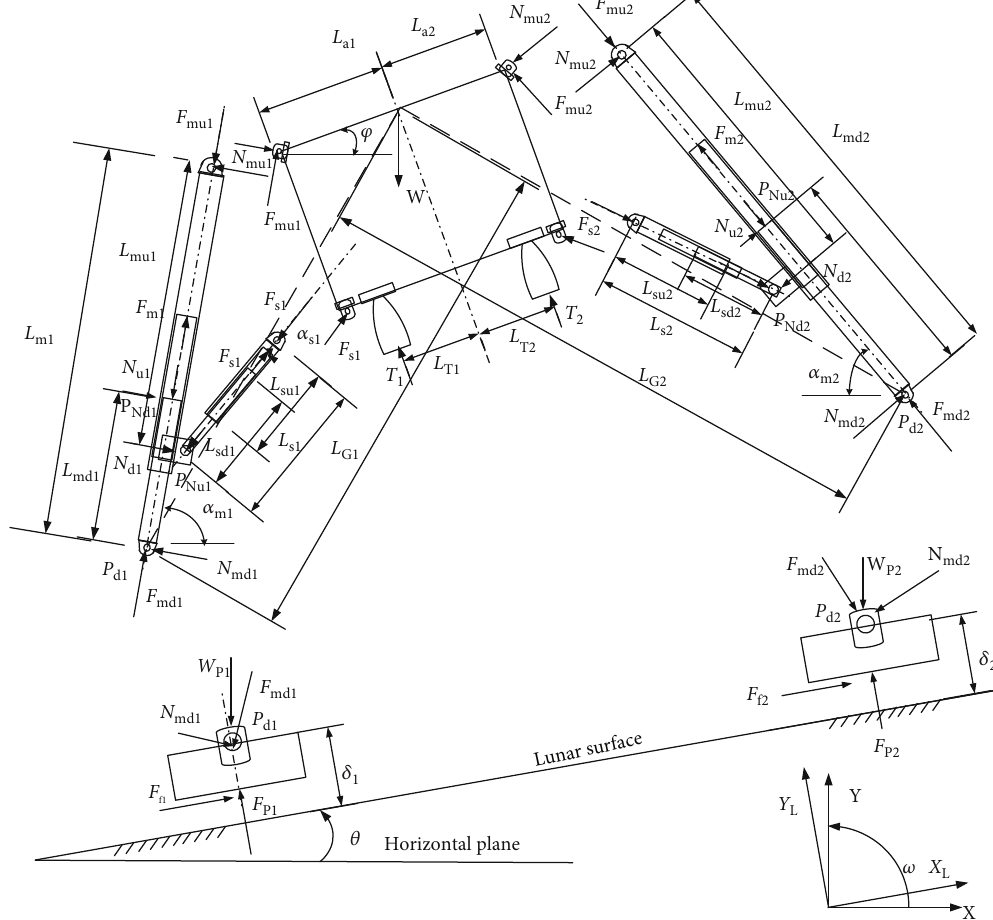
Figure 1: Lunar lander 2-2 mode soft-landing force